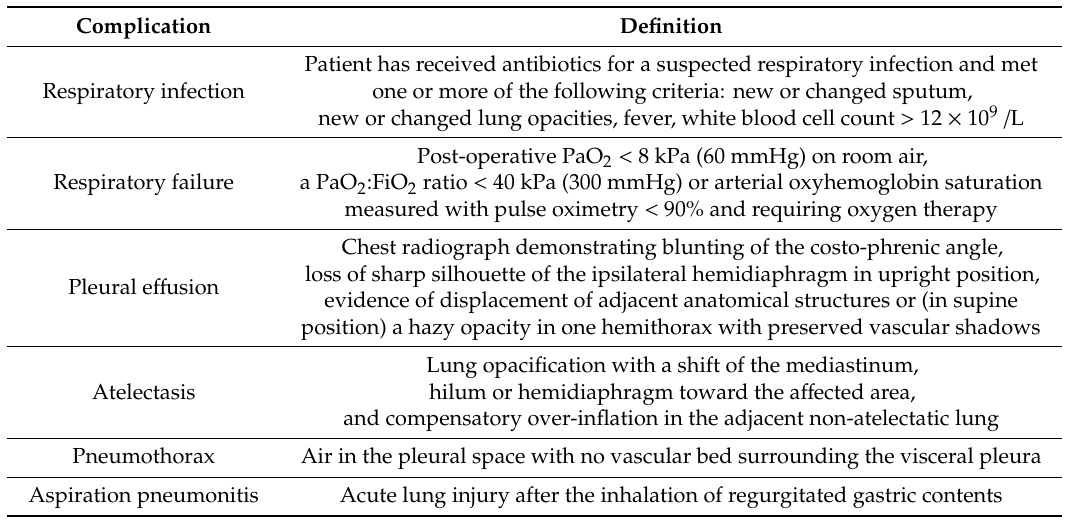
Table 1. Definition of post-operative pulmonary complications according to European perioperative clinical outcome (EPCO)